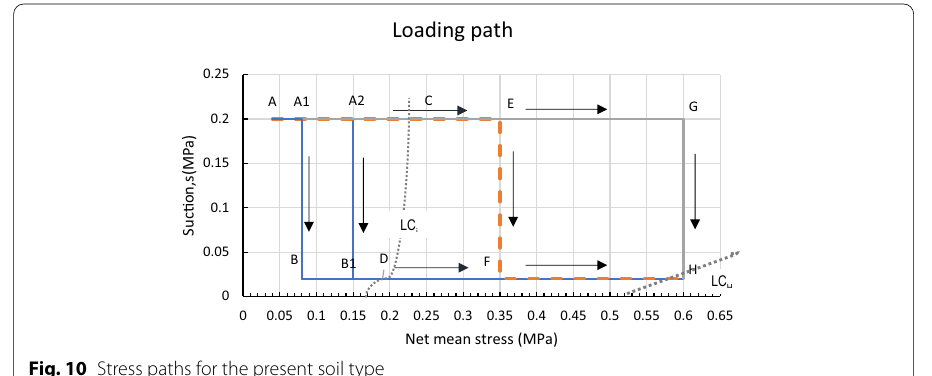
Fig. 10 Stress paths for the present soil type